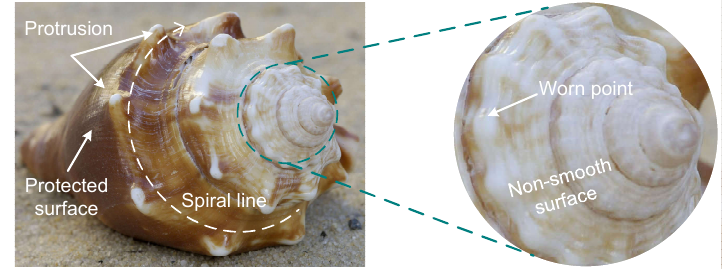
Figure 2. Biological characteristics of a